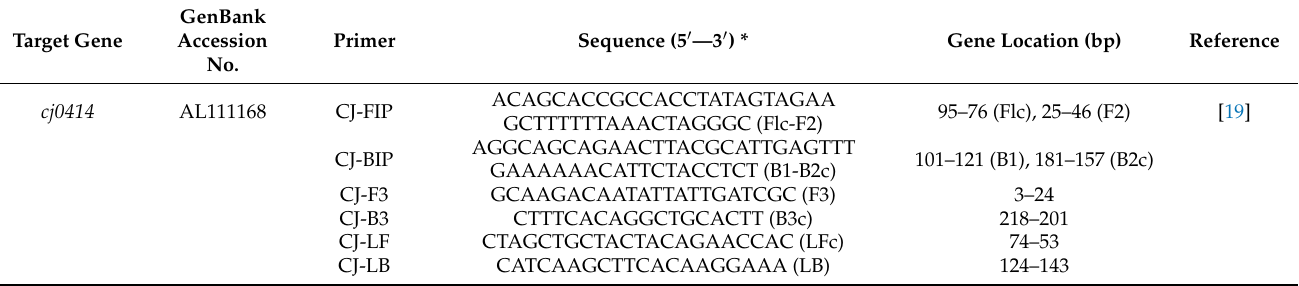
Table 1. Loop-mediated isothermal amplification (LAMP) primers used in this study.